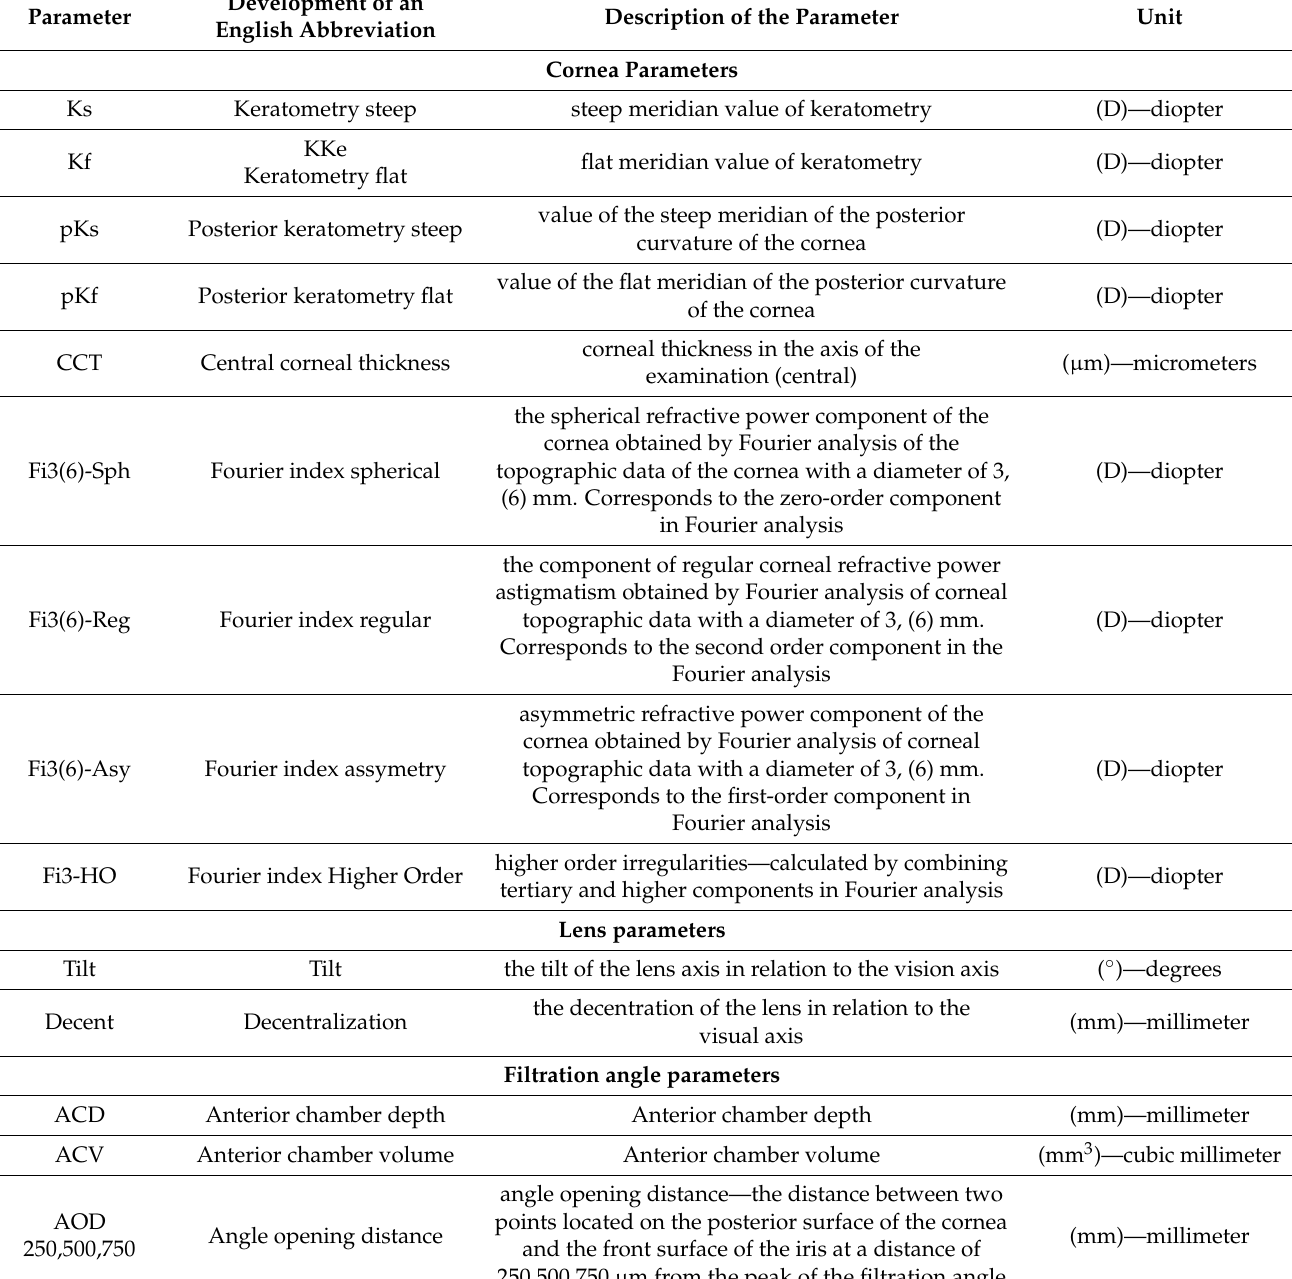
Table 1. Analyzed parameters of the anterior segment of the